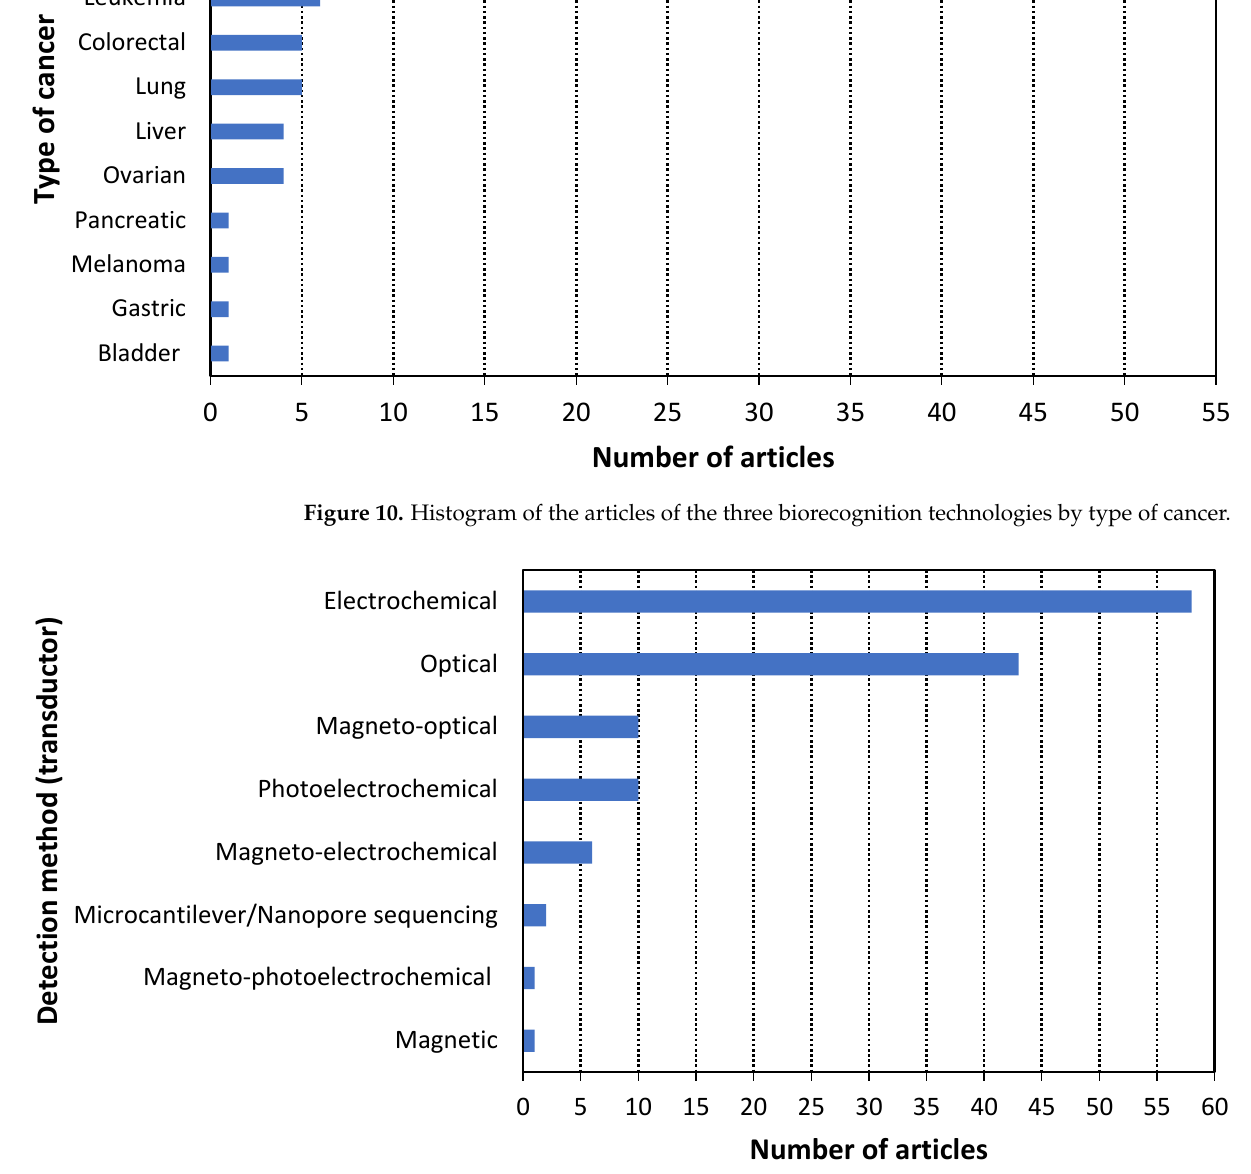
Figure 11. Histogram of the articles of the three biorecognition technologies by detection method.